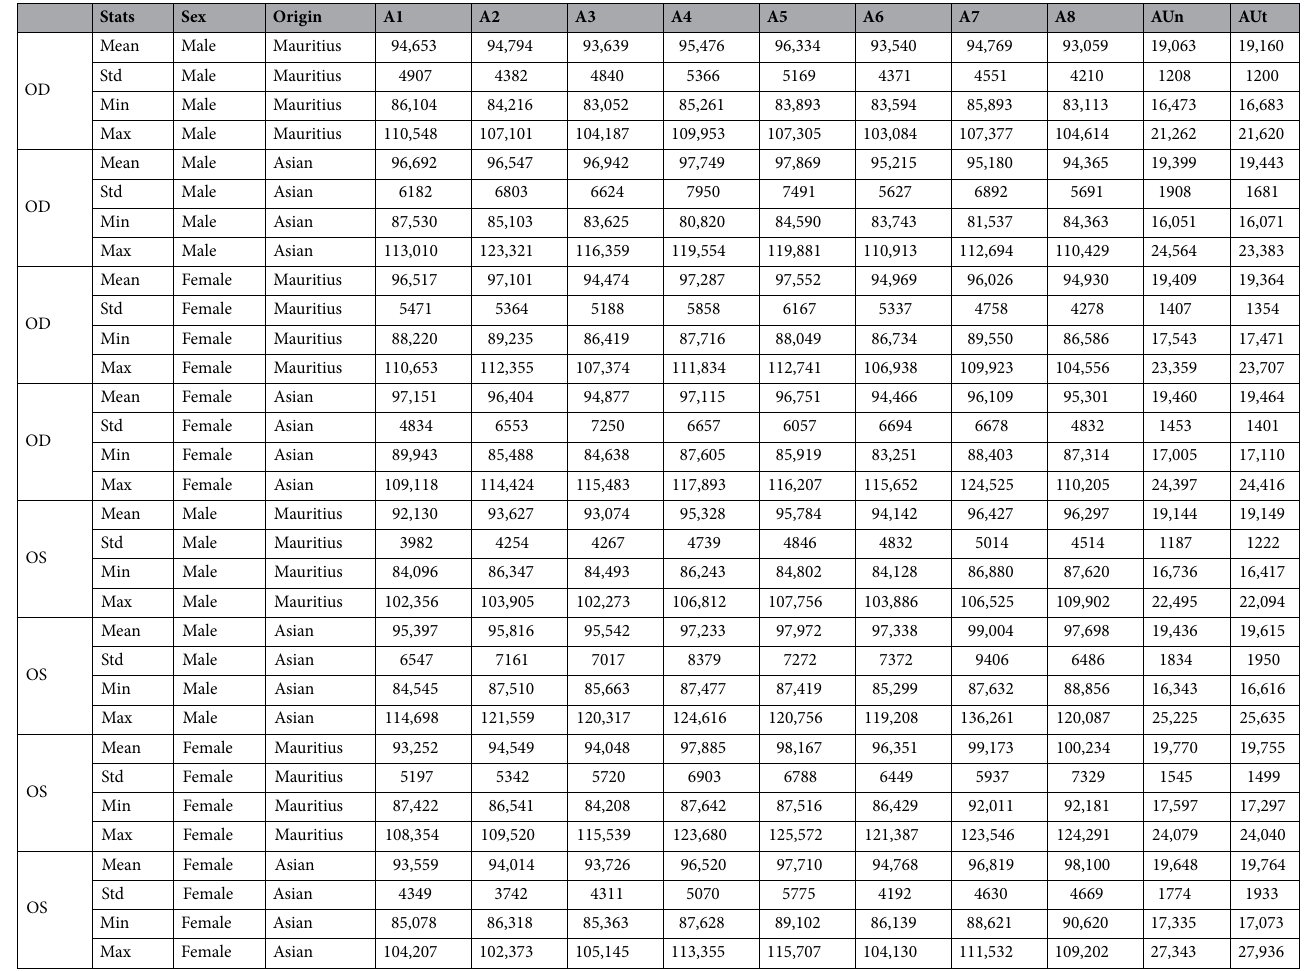
Table 3. Summary statistics of the choroidal area values. OD oculus dexter, OS oculus sinister, Stats statistical analysis, A choroid surface area, U umbo, n nasal, t temporal, std standard deviation, min minimum, max maximum, values in µm 2